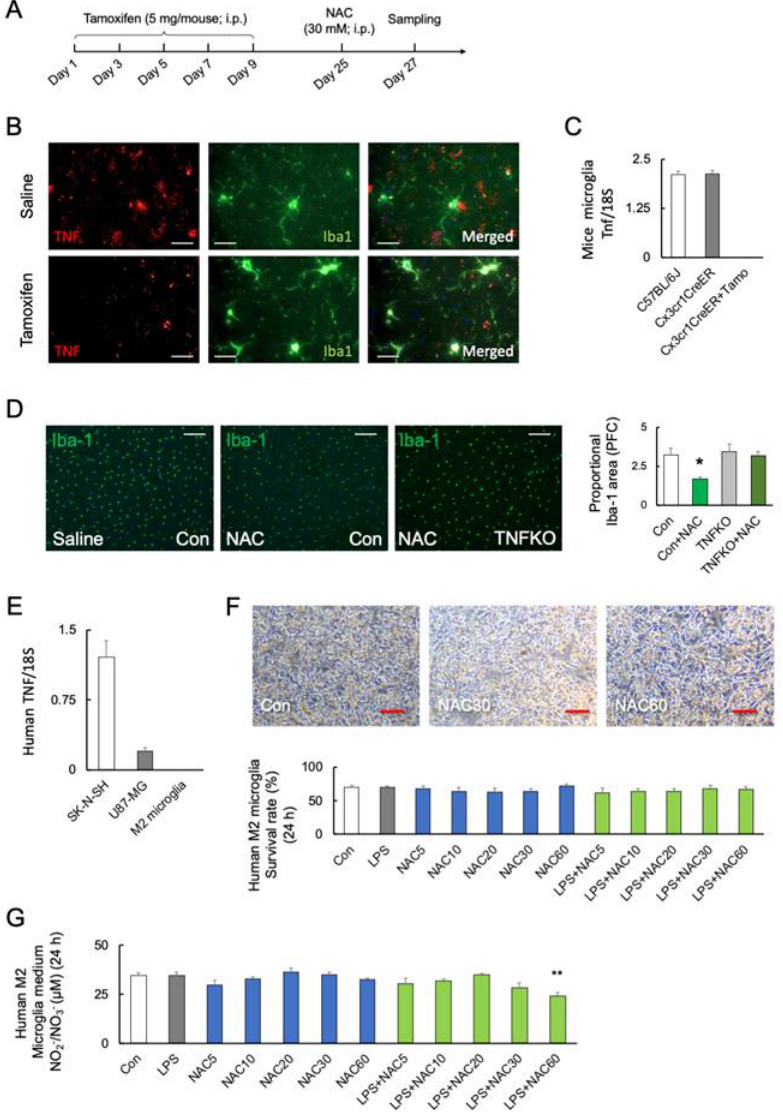
Figure 4. Role of microglial TNF- α in NAC-induced microglia mortality. ( A ) Experimental schedule. ( B , C ) Representative images and quantitative analyses of microglial TNF- α in the prefrontal cortex of C57BL/6J and TNF fl/fl Cx3cr1-Cre ER mice after saline or tamoxifen treatment. TNF- α and Iba-1 are shown in red and green, respectively. Scale bars, 100 µ m. ( C ) The transcript levels of microglial Tnf in C57BL/6J mice and TNF fl/fl Cx3cr1-Cre ER mice with or without tamoxifen (Tamo) treatment (n = 6). ( D ) Representative images and quantitative analyses of microglia viability after 48 h of NAC (30 mM; i.p.) treatment in C57BL/6J (n = 4) and microglial TNF- α -deficient mice (n = 4) with tamoxifen treatment (TNFKO). * p < 0.05, vs. saline (Con; C57BL/6J). Scale bars, 250 µ m. ( E ) Transcript levels of TNF in the SK-N-SH, U-87 MG, and human primary M2 microglia (n = 4). ( F ) Representative